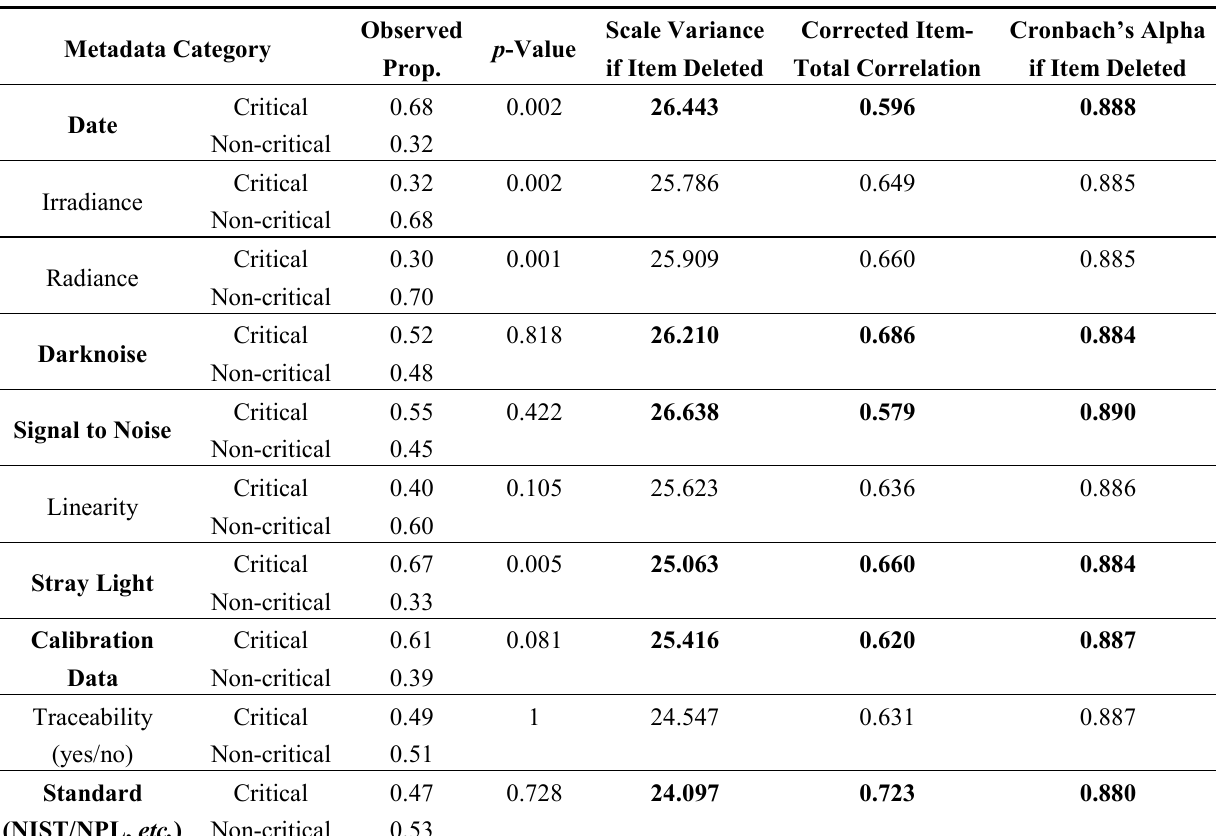
Table 2. Binomial test results and scale statistics analysis for ―calibration‖ metadata ( n =